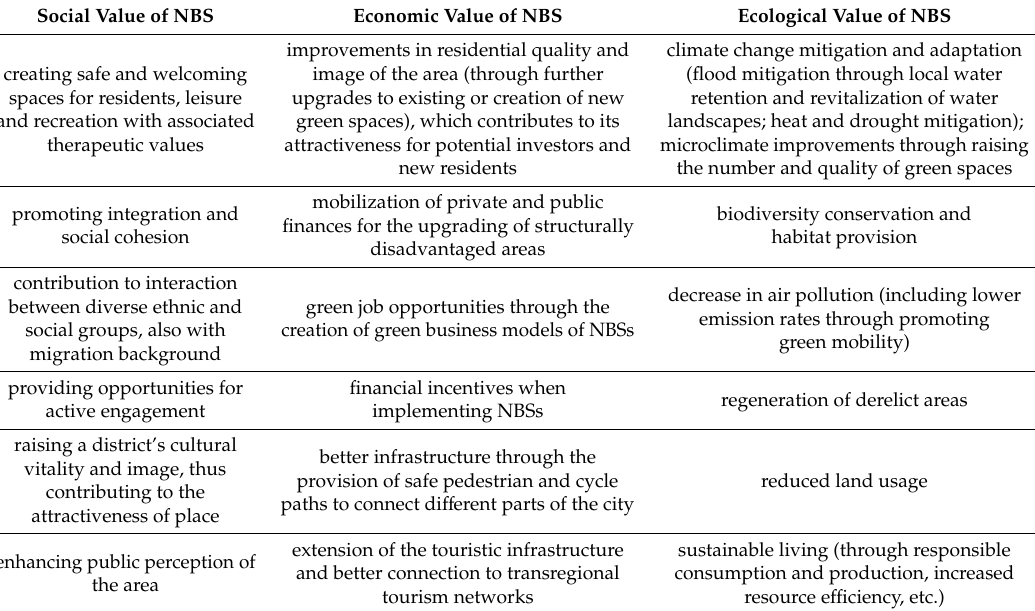
Table 3. Impact of NBS examples for environment, economics, society, and the sustainable development of Leipzig. Social Value of NBS Economic Value of